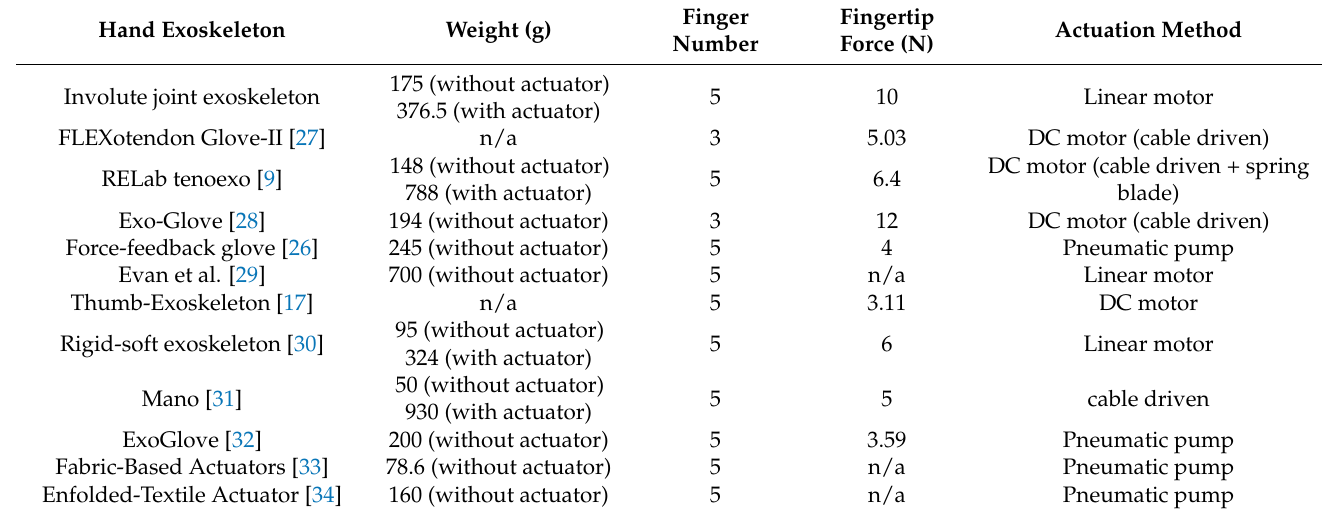
Table 3. Comparison of the proposed exoskeleton with other advanced